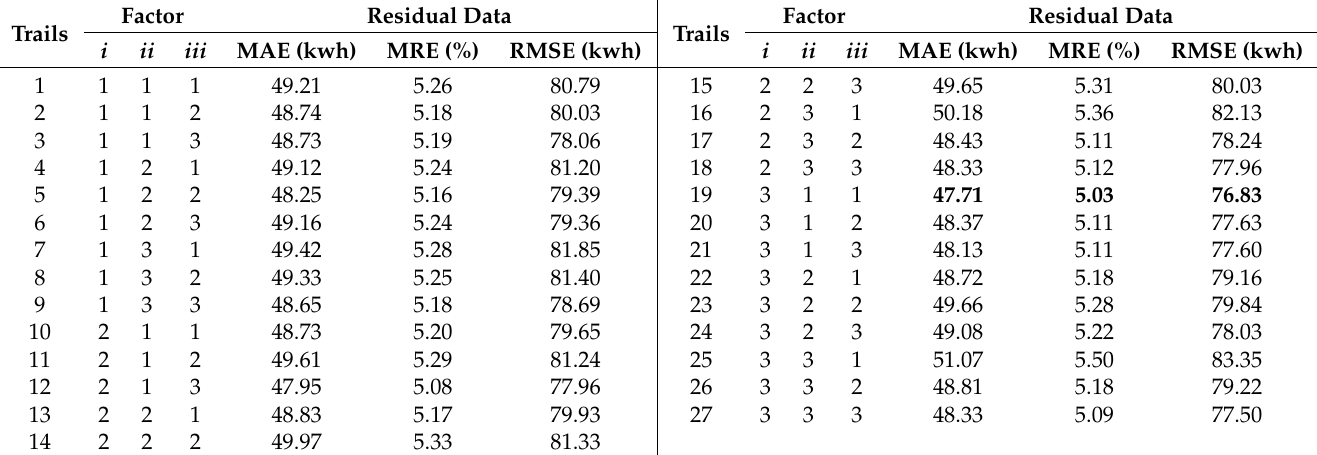
Table 2. Experimental results of the MDBN in 27 trails under the consideration of three design factors and their corresponding